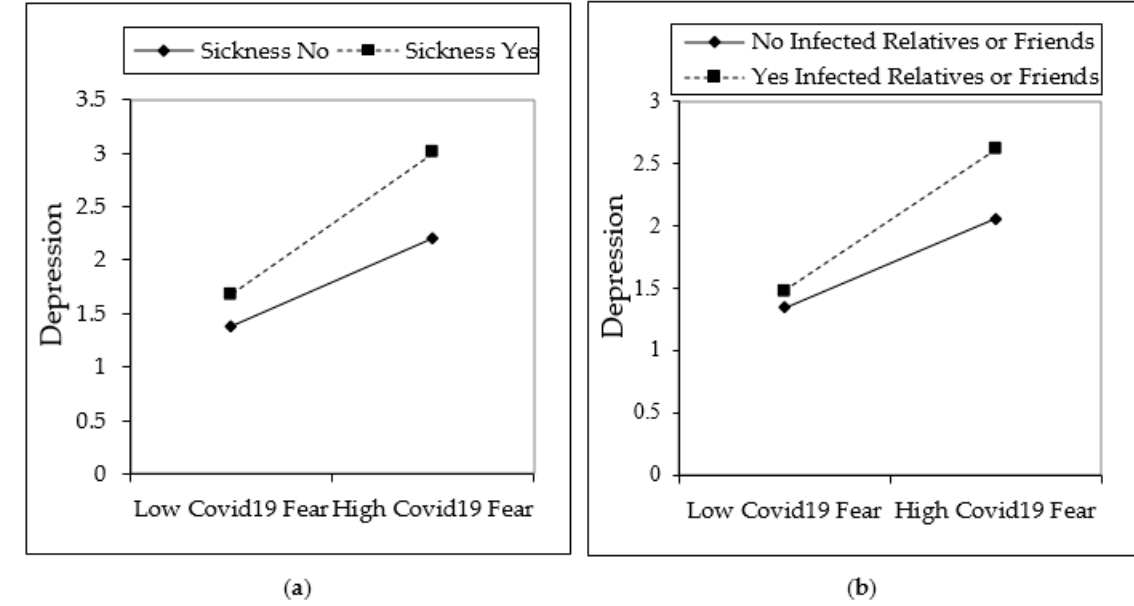
Figure 2. Interaction effects on depression. Moderators of underlying sickness is depicted in ( a ), having infected relatives or friends is depicted in ( b ).